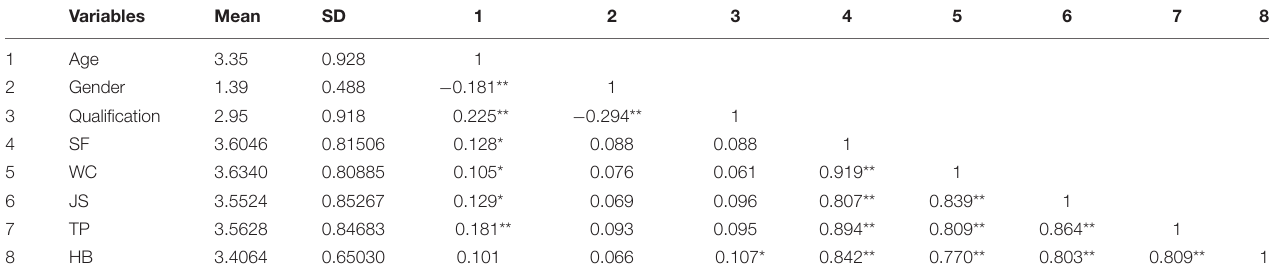
TABLE 2 | Means, SD, and inter-factor correlation.